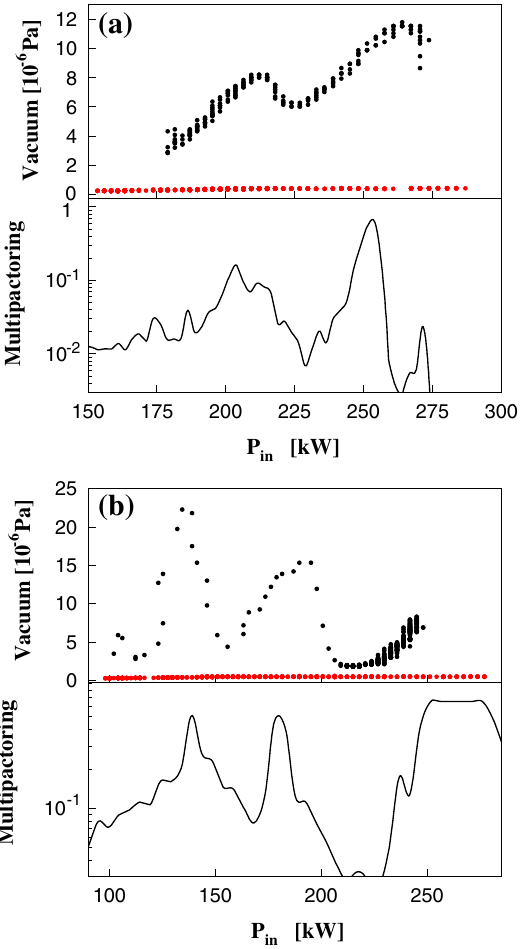
FIG. 15. Comparisons of the vacuum data on CavityM (upper) with the calculation results for M (lower) as a function of the input rf power for the operating points of CavityM (a) in the overcoupling, (b) optimum-coupling and undercoupling regions. The black (red) dots indicate measurements of the vacuum pressure without (with) grooves. The trajectories of the operating points for the black and red dots in (a) and the black and red dots in (b) are shown in Figs. 16(a)–16(d), respectively.